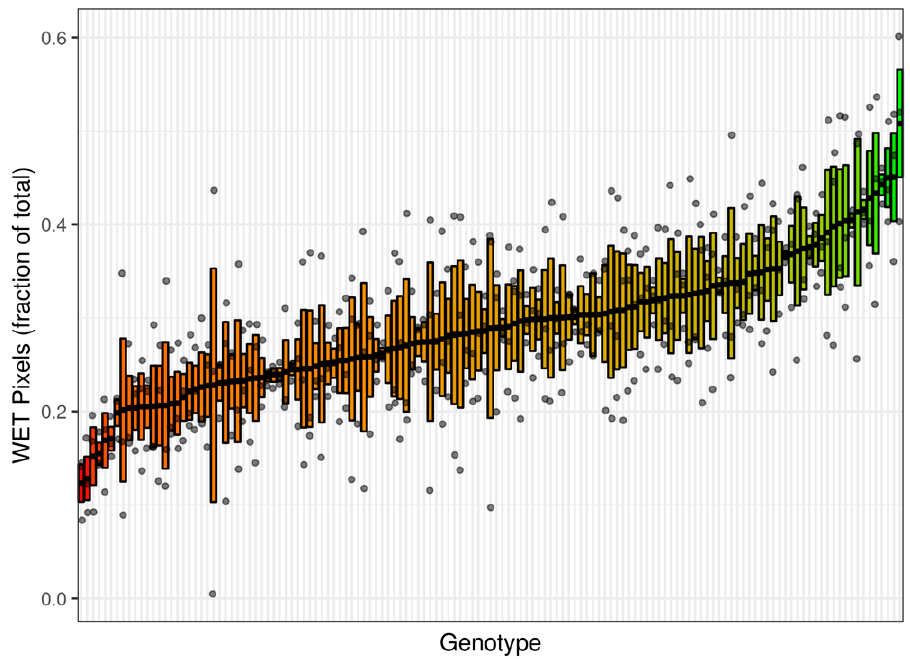
Figure 3. Classification of 411 plants based on the number of scored WET pixels based on the analysis of the NIR images.